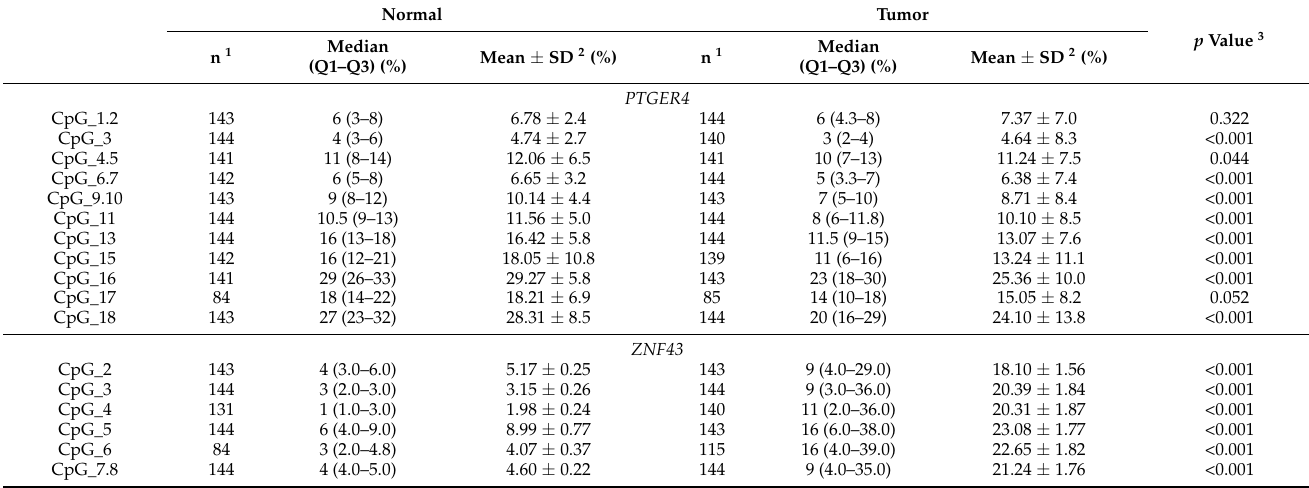
Table 3. Comparison of methylation level at specific CpG sites of PTGER4 and ZNF43 in normal tissue and tumor tissue (n =